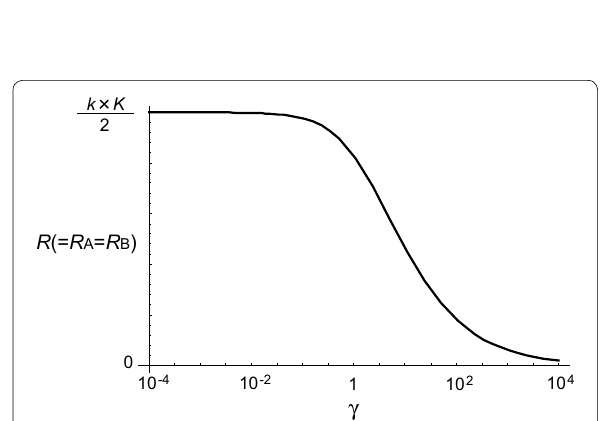
Fig. 5 The plot of the reaction rate as a function of γ when δ = 1 . In this case, the reaction rates R A and R B are observed to be equivalent. For small γ , the rate is independent of γ and is only dependent on k and K , indicating that it is surface-controlled. However, for large γ , the rate depends on k , K , and D , indicating a combined surface reaction and diffusion control (see